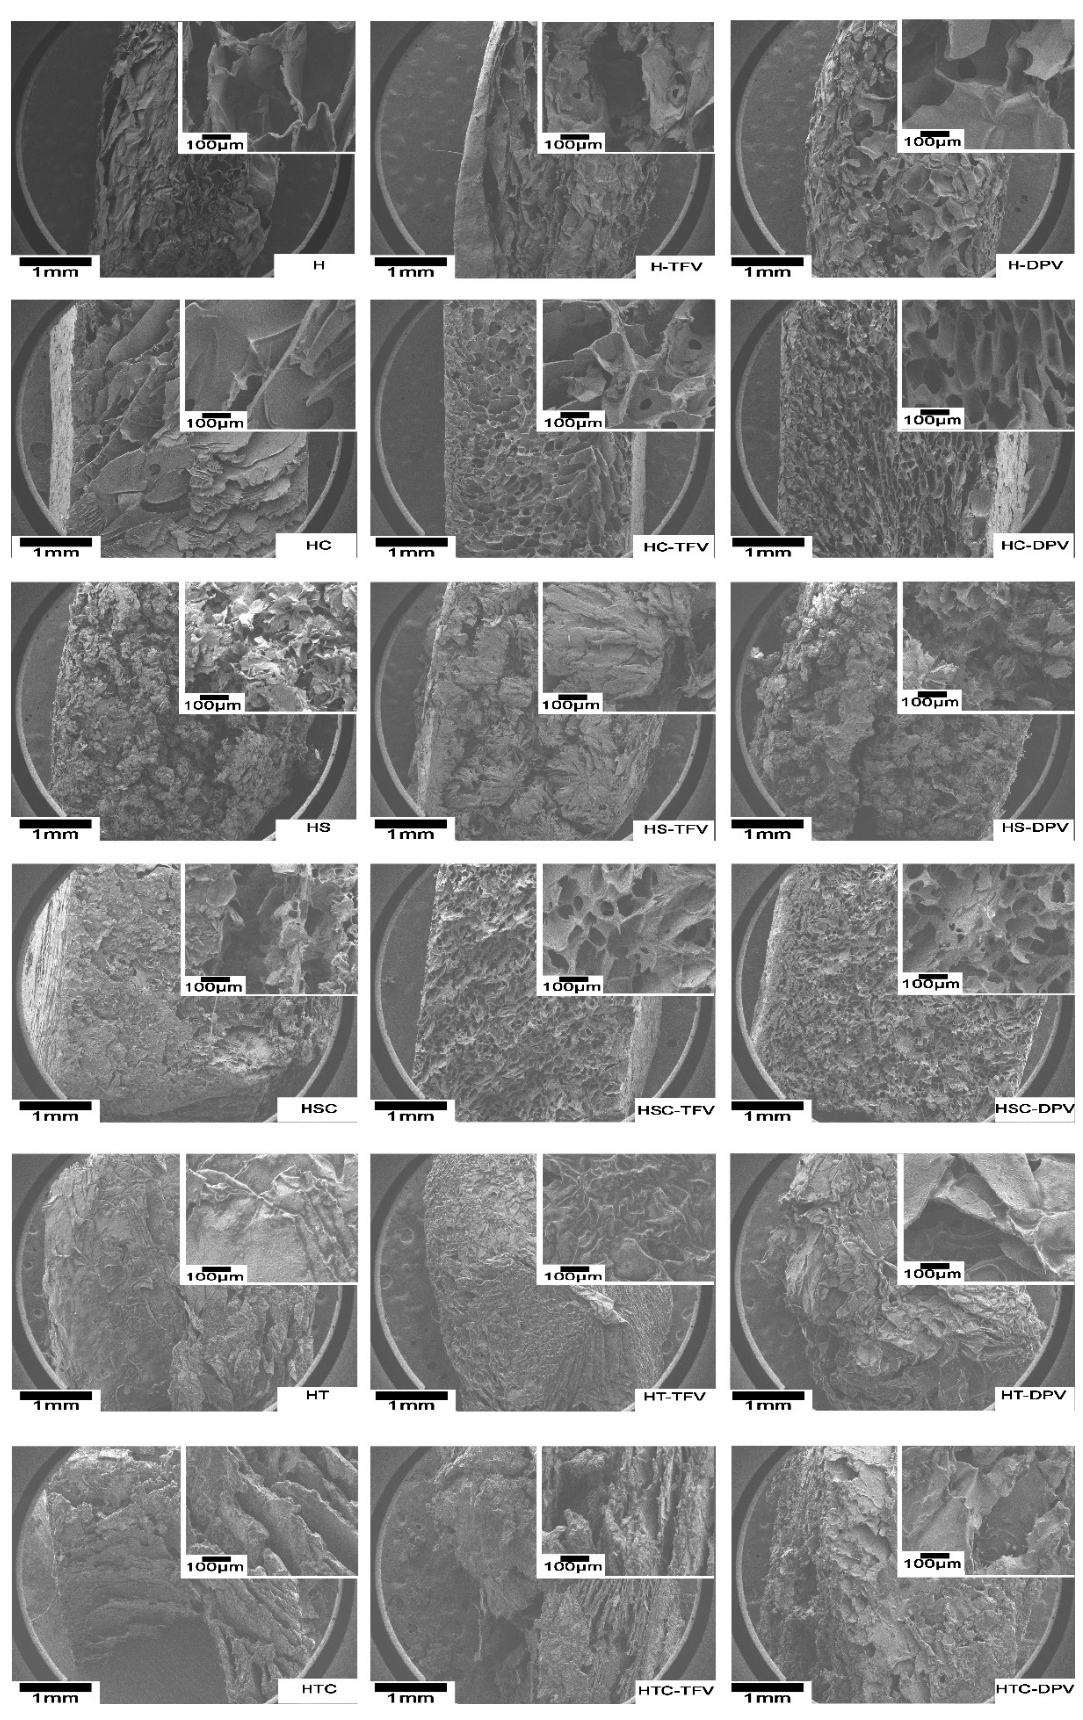
Figure 6. Scanning electron micrographs of vaginal discs.